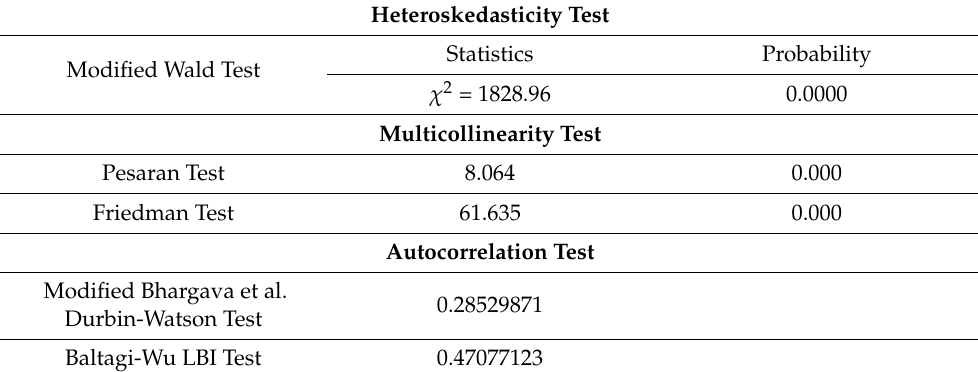
Table 8. Hypotheses test